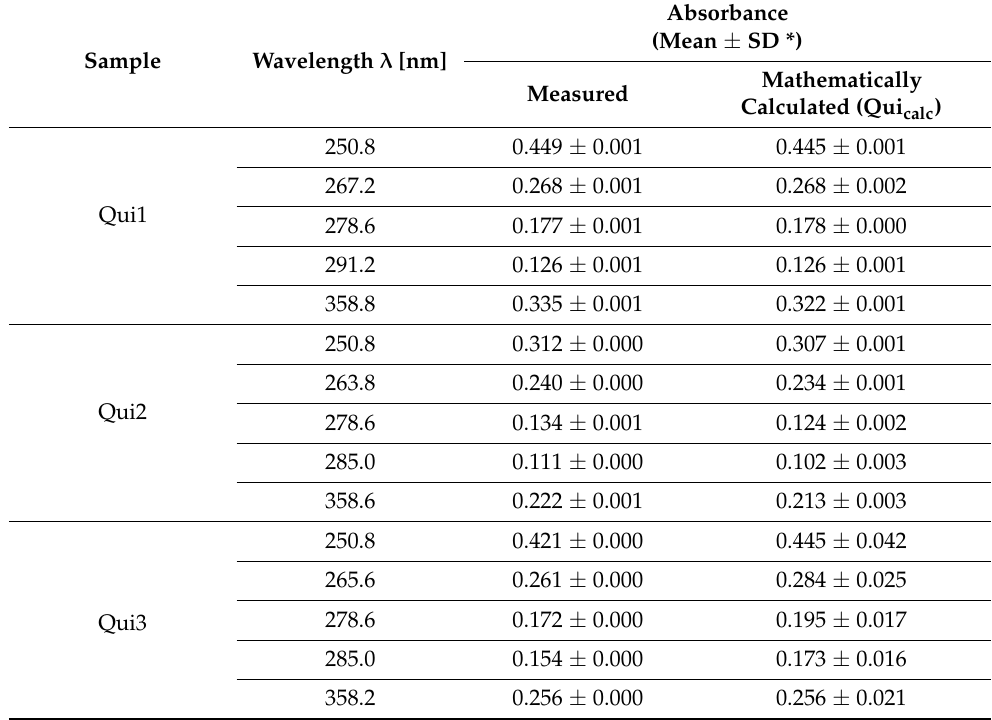
Table 2. The values of mean absorbance, both experimentally measured and mathemati- cally calculated of Qui1, Qui2, Qui3, as well as Qui1 calc = (Qui1 + HSA) complex − HSA, Qui2 calc = (Qui2 + HSA) complex − HSA and Qui3 calc = (Qui3 + HSA) complex − HSA; Qui1, Qui2 and Qui3 concentration 2.5 × 10 − 5 M, HSA concentration 1.25 × 10 − 5 M, ligand: HSA molar ratio (in (Qui-HSA) complex ) 2:1. Absorbance (Mean ± SD *) Sample Wavelength λ [nm] Mathematically Measured Calculated (Qui calc ) 250.8 0.449 ± Qui1